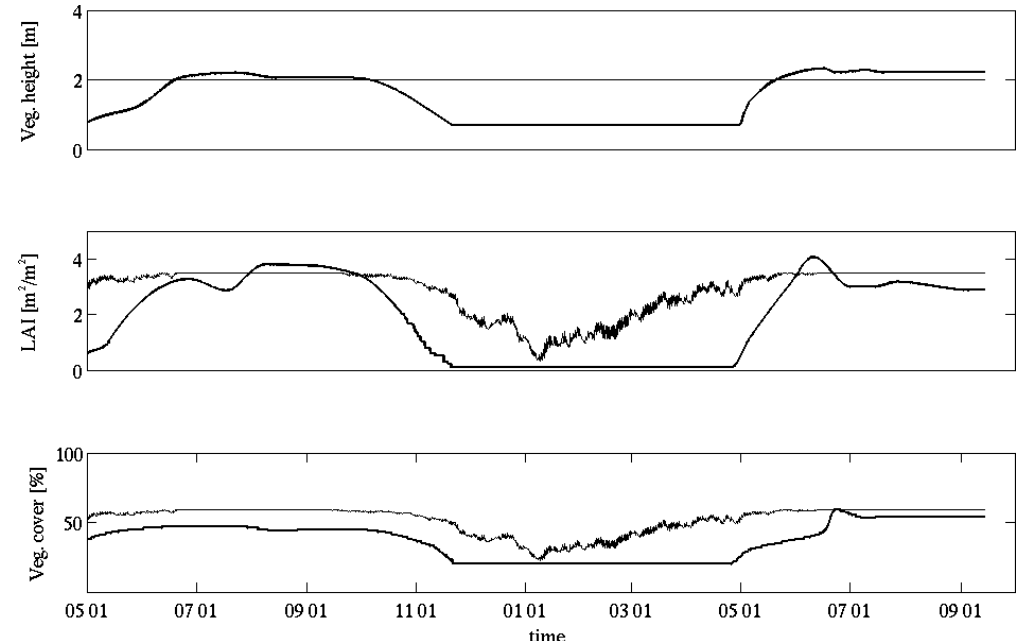
Figure 8. Initialization of vegetation height, LAI and vegetation cover in the experimental run (thick line) and in the control run (thin line) from May 2008 to September